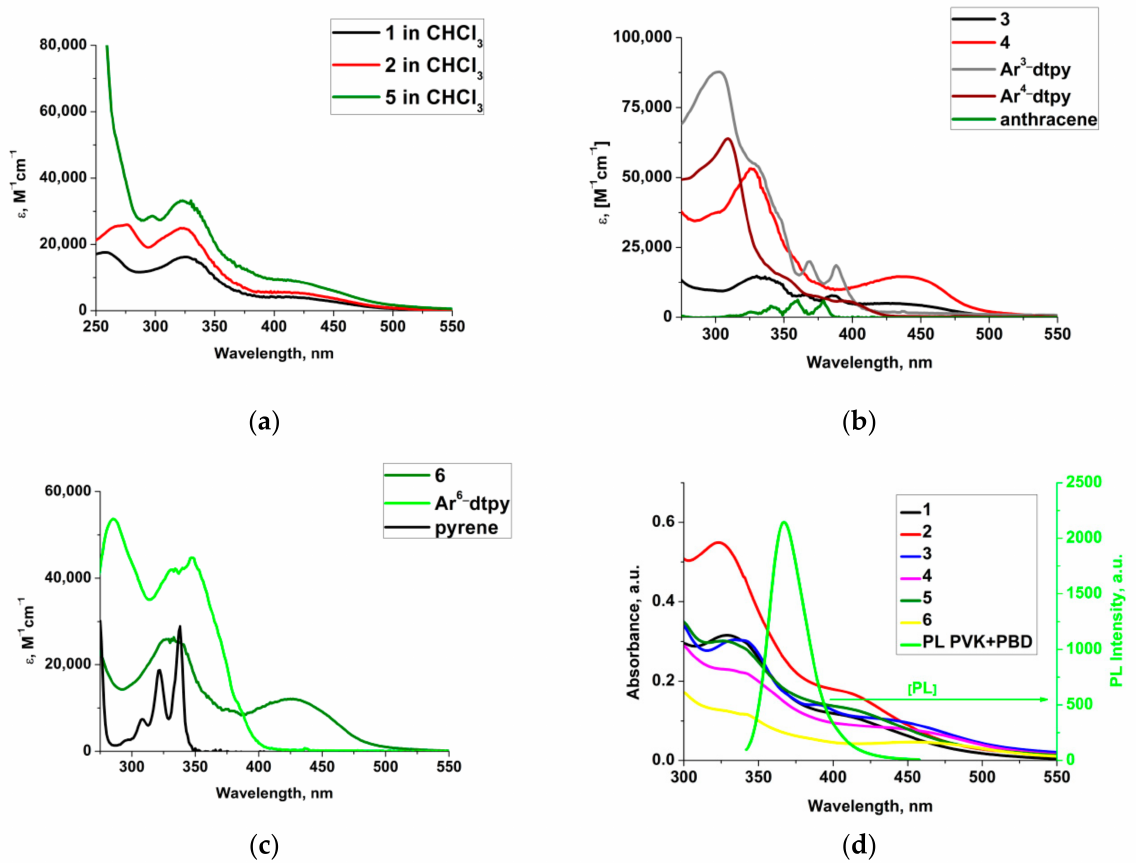
Figure 3. UV–Vis absorption spectra of: ( a ) complexes 1 – 2 and 5 in CHCl 3 ; ( b ) complexes 3 – 4 , Ar 3,4 -dtpy and anthracene in CHCl 3 ; ( c ) complex 6 , Ar 6 -dtpy and pyrene in CHCl 3 ; ( d ) and in film together with photoluminescence (PL) spectrum of PVK: